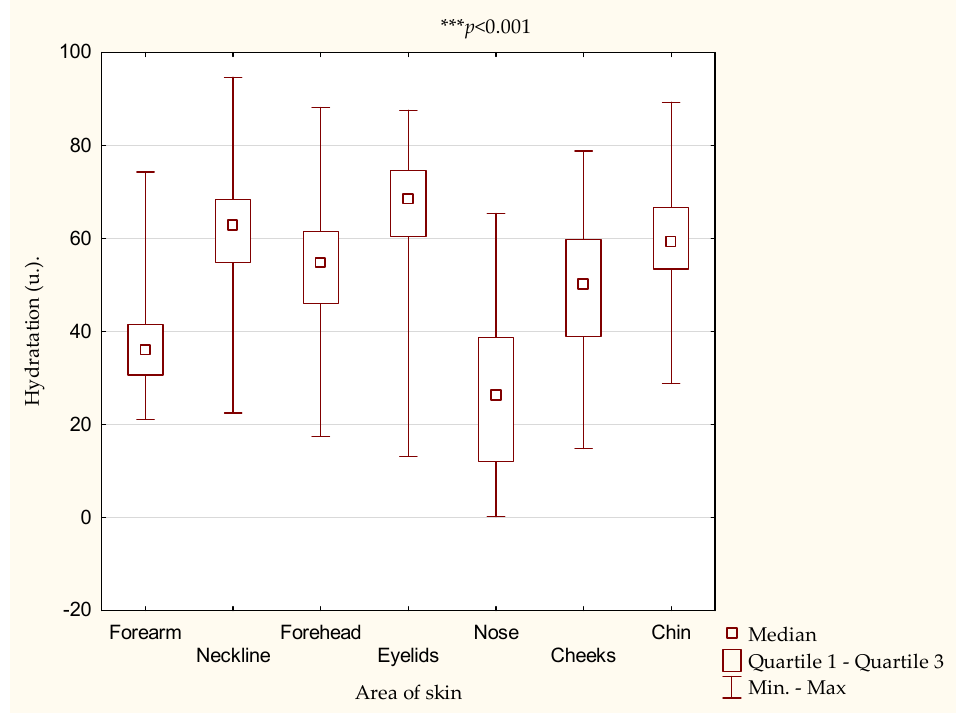
Figure 1. Differences in hydration of the body and face skin. Av.—average, SD—standard deviation. The assessment of the lubrication of the face skin showed that the most sebum was present on the skin of the nose (105.13 ± 73.53 µ g/cm 2 ) and forehead (103.62 ± 65.69 µ g/cm 2 ). The degree of lubrication significantly depended on the area of the skin (Figure 2).